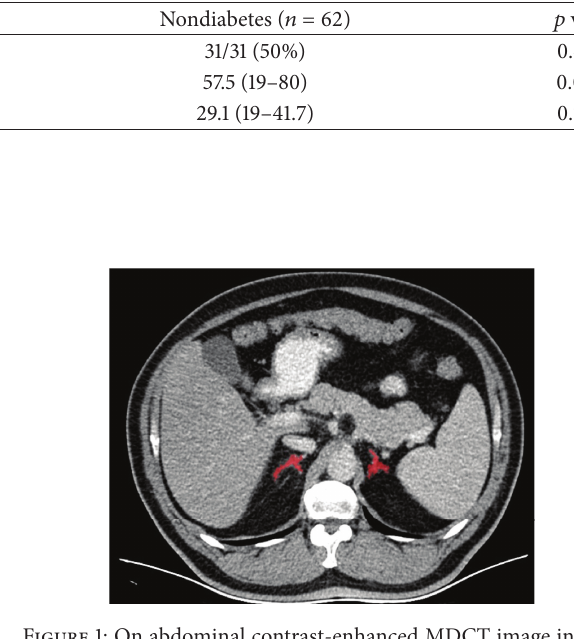
Figure 1: On abdominal contrast-enhanced MDCT image in axial plane was seen semiautomatically traced adrenal gland contour for each side.